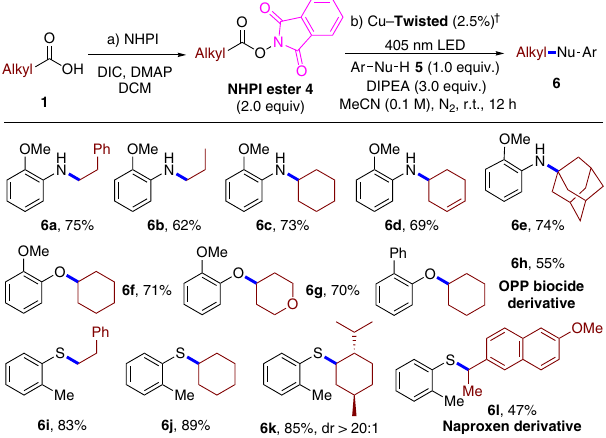
Fig. 6 Decarboxylative C(sp 3 ) – heteroatom coupling by Cu – Twisted. † Conditions: Cu – Twisted (2.5%), 5 (0.3 mmol, 1.0 equiv.), 4 (2.0 equiv.), DIPEA (3.0 equiv), MeCN (0.1 M), 405 nm LED, N 2 , r.t., 12 h. Isolated